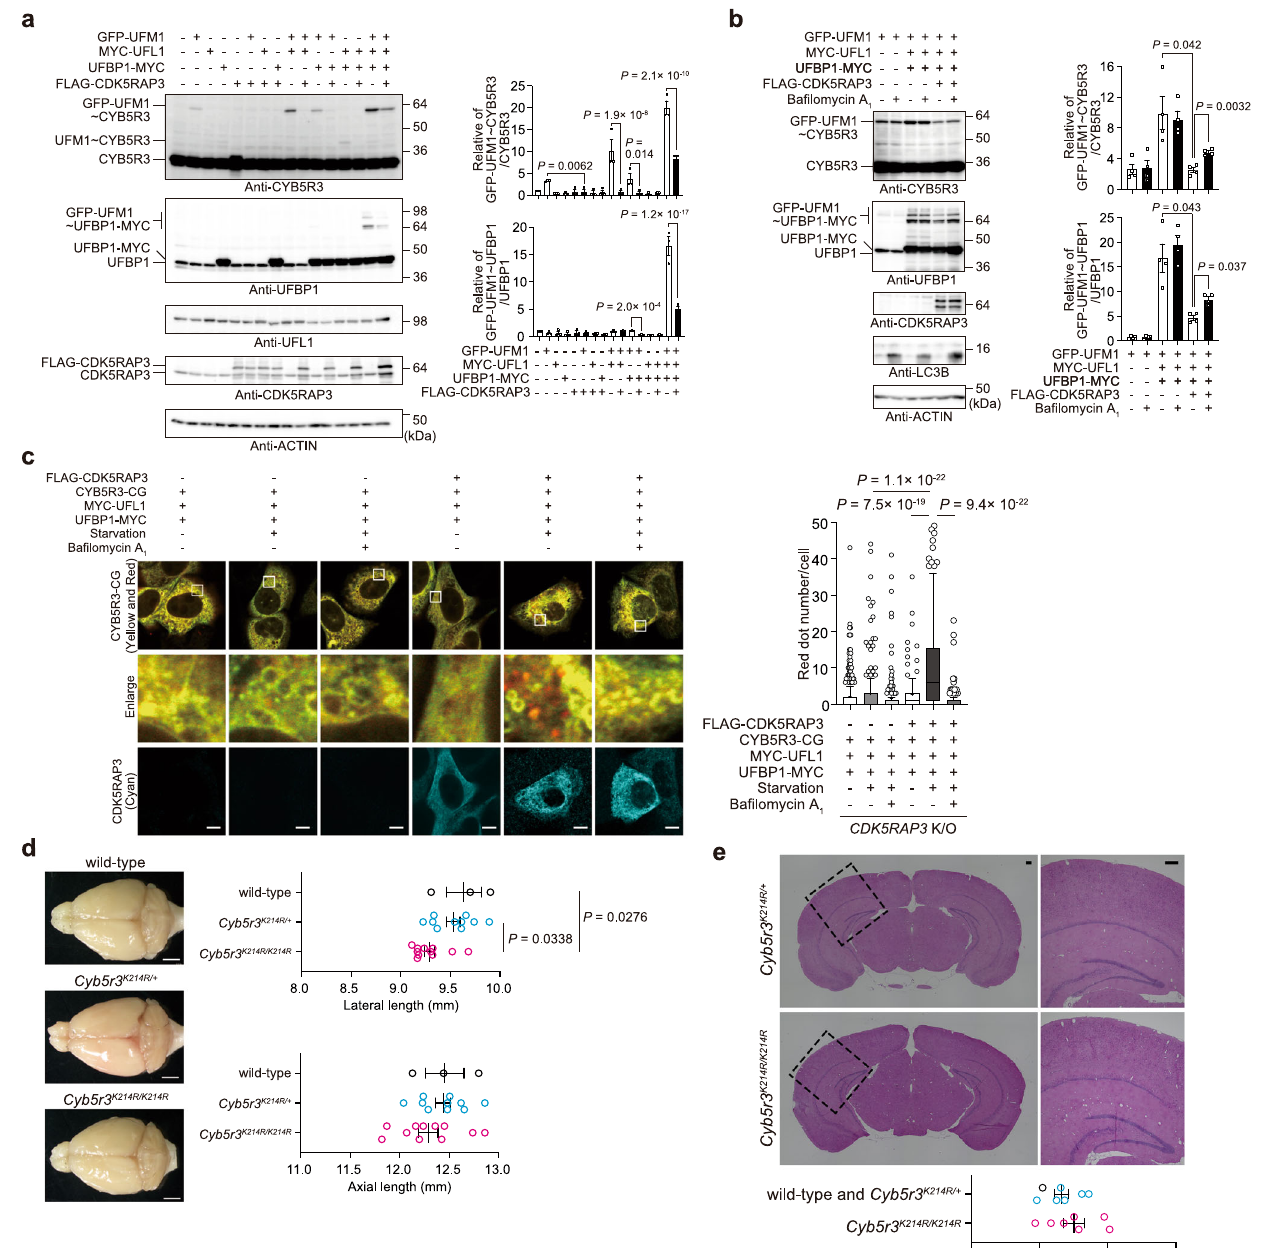
Fig. 6 | CDK5RAP3 is indispensable for ufmylation-mediated ER-phagy. a – b UFSP2 − / − ( a ) or CDK5RAP3 − / − UFSP2 − / − HEK293T ( b ) expressing indicated con- structswereculturedundernutrient-richconditions( a )inthepresenceorabsence ofBa fi lomycinA 1 for12h( b ). . Lysatesweresubjectedtoimmunoblotanalysis.Data shown are representative of three separate experiments. Bar graphs show the results of quantitative densitometric analysis of the indicated proteins relative to free CYB5R3 or free UFBP1. Data are means±s.em. Statistical analysis was per- formed by Š idák ’ s multiple comparison test after one-way ANOVA. c Fluorescence microscopic analysis. CDK5RAP3 − / − HeLa expressing indicated constructs were analyzed as described in Fig. 5b. The numbers of cells used to count the mCherry- positive punctae were 337, 235, 191, 127, 113, and 92 from lanes 1 to 6. Bars: 10 μ m. Horizontal bars indicate medians, boxes in the interquartile range (25th – 75th percentiles), and whiskers 1.5× the interquartile range; outliers are plotted indivi- dually. Data are means±s.e. Statistical analysis was performed by Š idák ’ s multiple